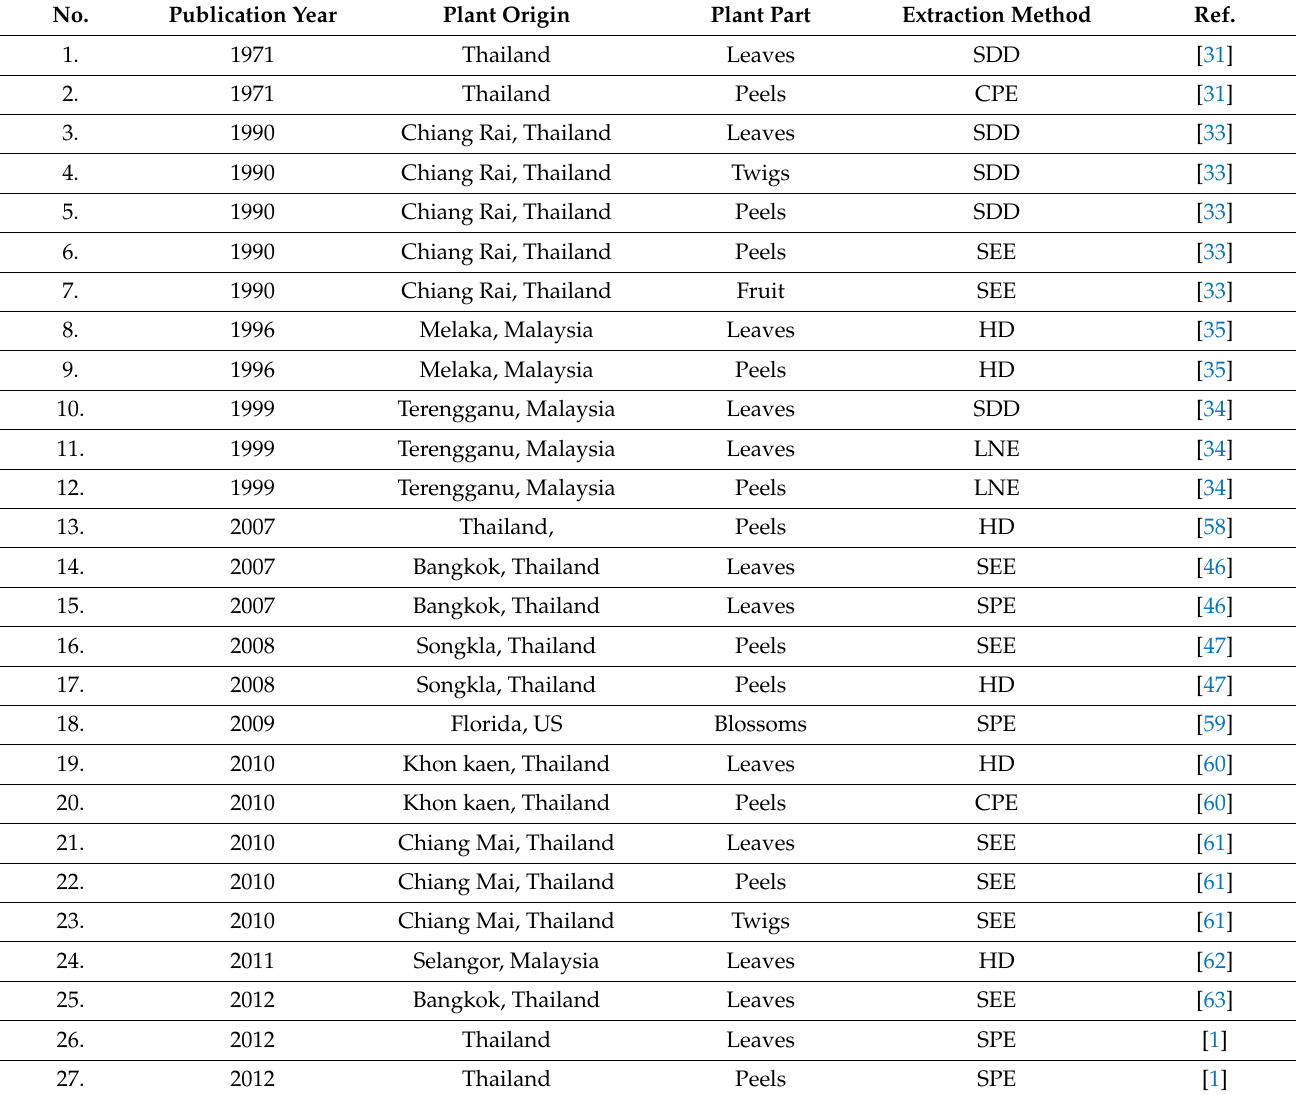
Table 1. Database for meta-analysis of kaffir lime essential oil variation in the last fifty